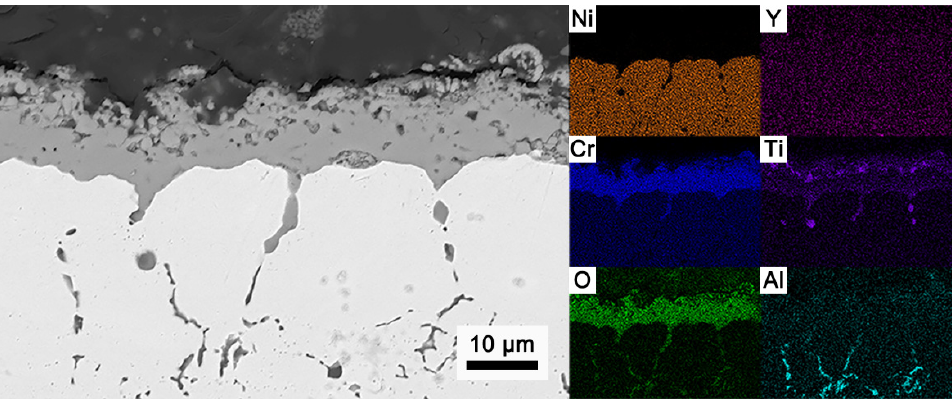
Figure 6. Cross-sectional SEM micrograph and element distribution of oxide scales on S1 after oxidation in air at 1000 °C for 200 h.